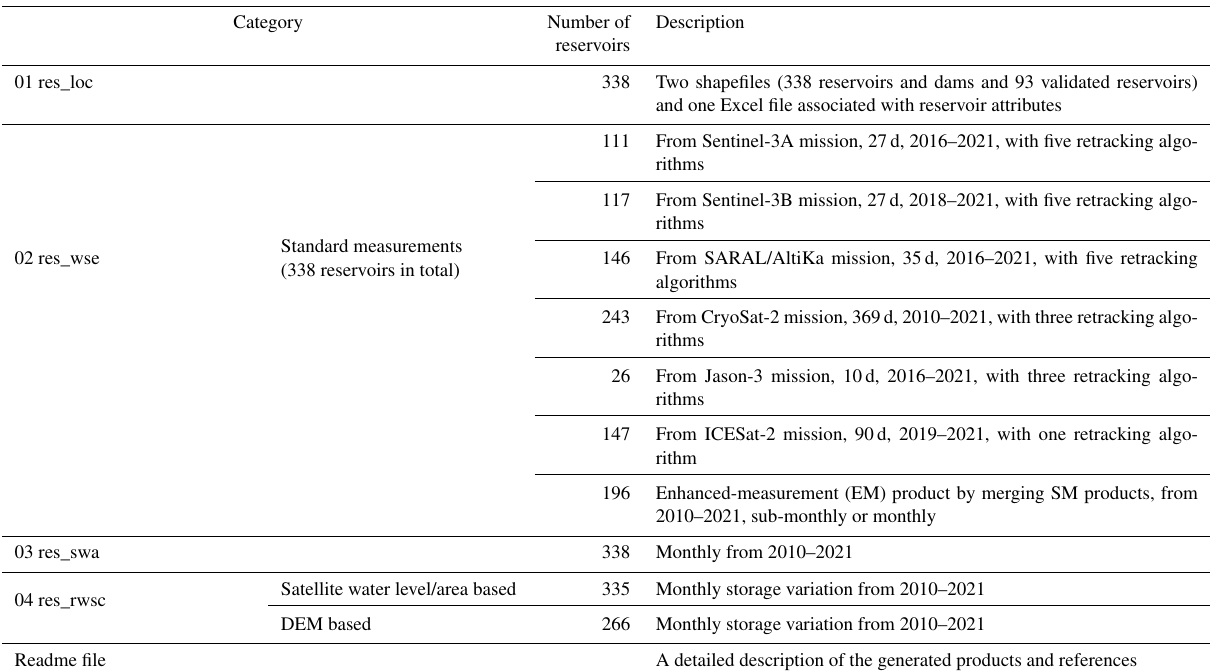
Table 3. Summary of the data provided in this study.